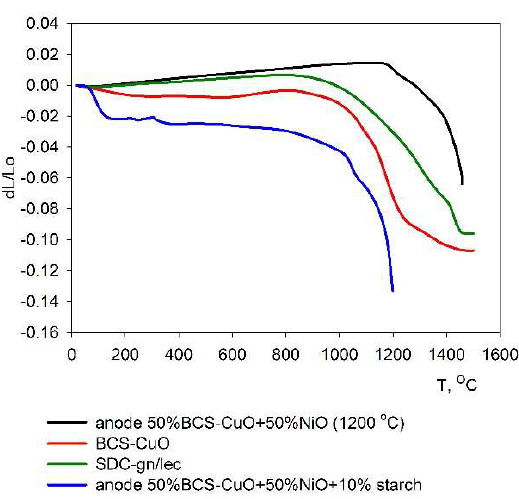
Figure 6. Dilatometric shrinkage curves of the SDC-gn/lec and BCS-CuO electrolyte materials, the 50 wt% NiO + 50 wt% BCS-CuO + 10 wt% starch anode material and the 50 wt% NiO + 50 wt% BCS-CuO anode material, pre-sintered at 1200 °C.